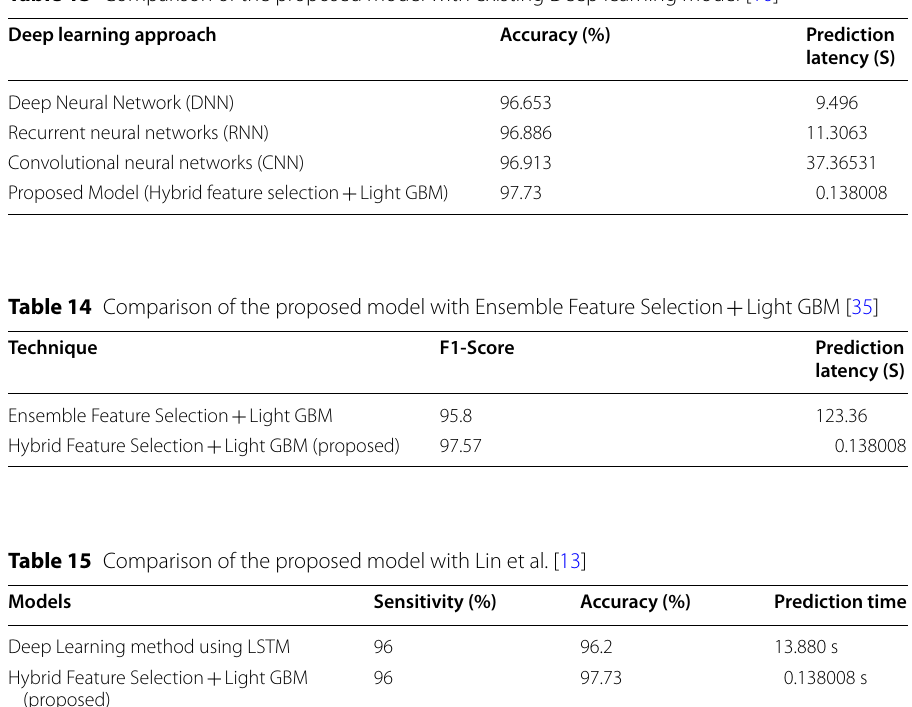
Table 13 Comparison of the proposed model with existing Deep learning model [16] Deep learning approach